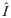
Hierarchical network decision regimes produce linear and nonlinear operations.I: input; I^: input normalized by the maximum input value; T: the transformed output of an intermediate layer; J+: excitatory weight; J−: inhibitory weight; red: choice alternative A; blue: choice alternative B; green: trajectory from a starting point of (0.06, 0.06); solid circles: stable fixed points; large solid circle: trajectory endpoint. (A) Using fixed point approximations, the E/I tone space can be partitioned according to decision regimes similar to the full model. The color scheme is the same as Fig 2D. (B) Phase portraits and bifurcation diagrams show that regimes III performs a highly-nonlinear winner-take-all operation. The E/I tone is provided both in the heading, and indicated in (A) by the lower-case marker. The top row contains phase portraits produced by a specific set of inputs (IA,x = 20, IB,x = 18). The relative value of the inputs is indicated by the vertical dashed line in the bifurcation diagrams of the second row. To produce the bifurcation diagrams, the input-output of a single attribute value is varied (IA,x) while the other (IB,x) is fixed. The difference between the normalized fixed (I^B,x) and the varied value (I^A,x) is on the X-axis. The T value of the endpoints is on the Y-axis. Individual trajectory endpoint values TA,x (red) and TB,x (blue) values are plotted, along with lines joining them when needed to aid visualization.